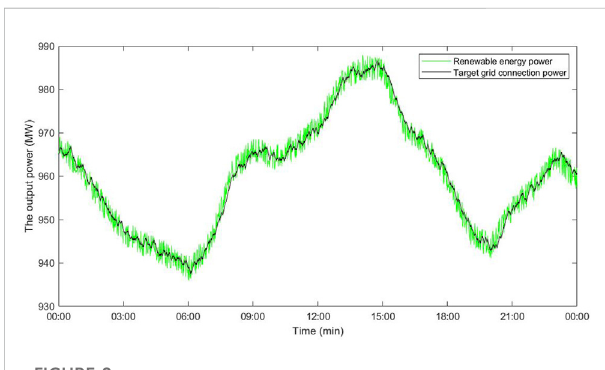
FIGURE 8 Renewable energy grid-connected target output